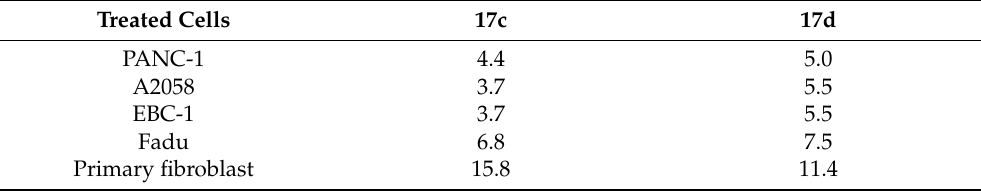
Figure 4. Dose–response curves of the two most potent imipridone hybrids, 17c and 17d, on different cancer cell lines, and on nontumorous primary fibroblast cells, after 72 h of treatment. Cell viability was determined by CellTiter-Glo assay. Curves were fitted by GraphPad Prism 8 software using nonlinear regression (variable slope; n = 3). Table 3. IC 50 values (µM) of the two most potent imipridone hybrids, 17c and 17d, on cancer cells and on nontumorous primary fibroblast cells after 72 h of treatment, based on CellTiter-Glo cell viability assay. IC 50 values were determined by GraphPad Prism 8 software (nonlinear regression; variable slope; best-fit values; n = 3).